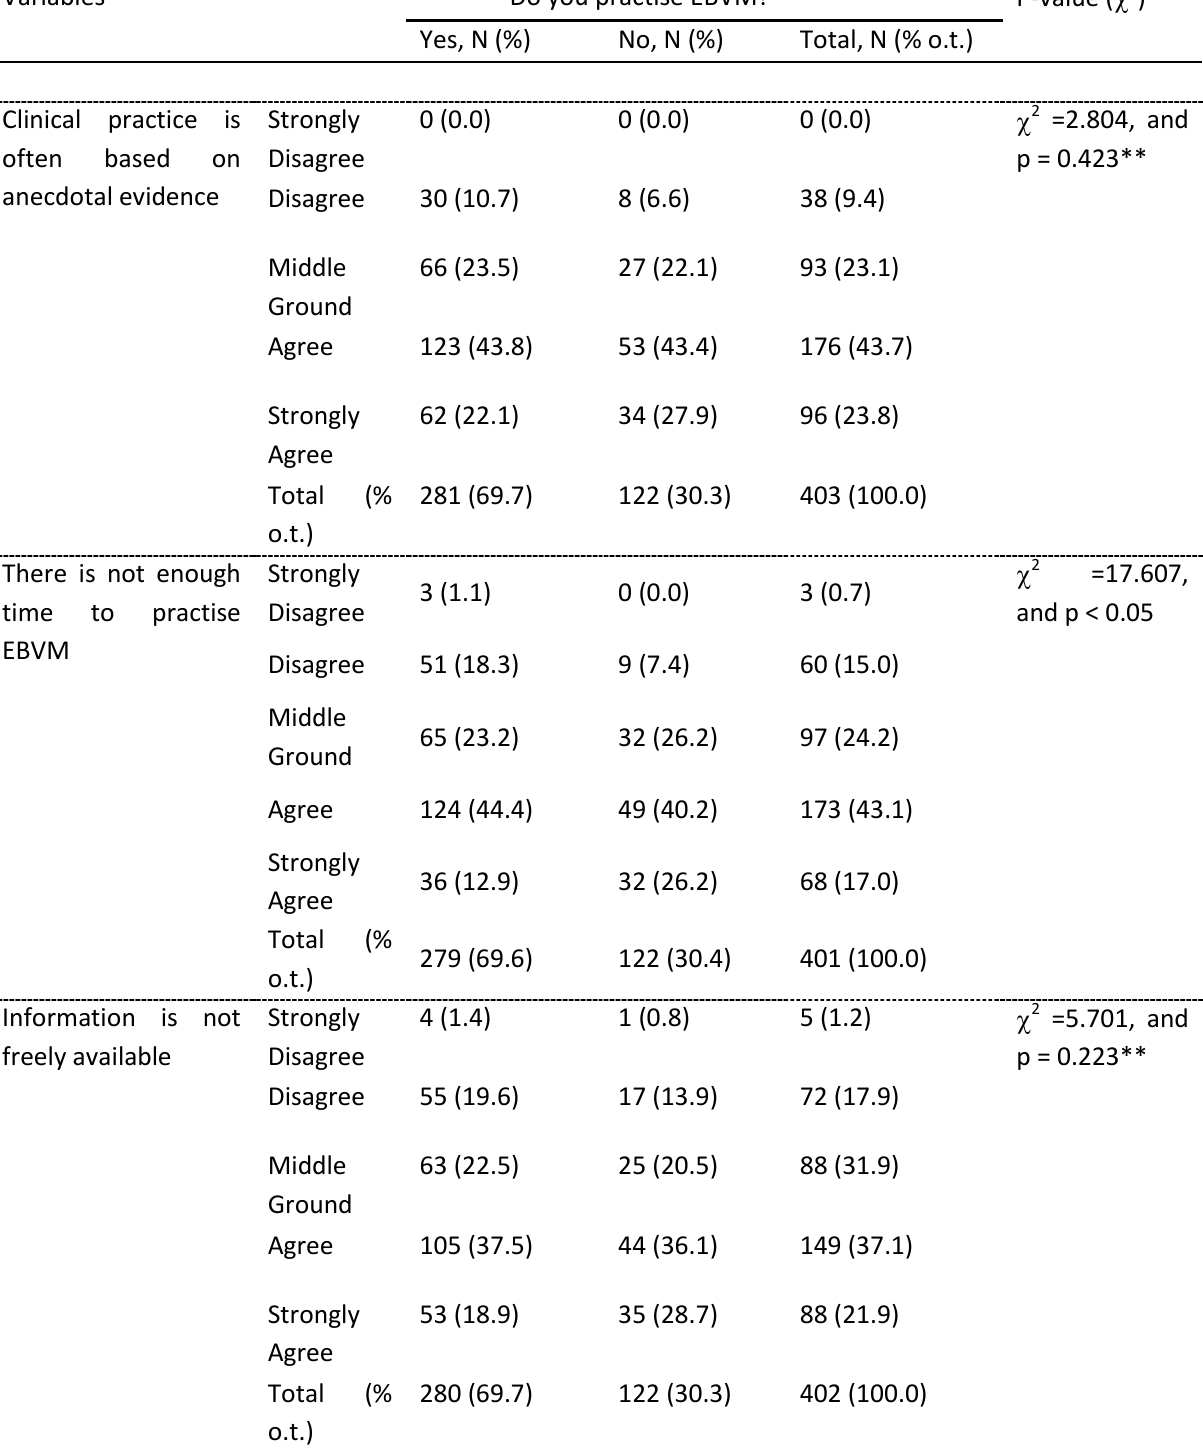
Table 8 : The barriers to EBVM I Variables Do you practise